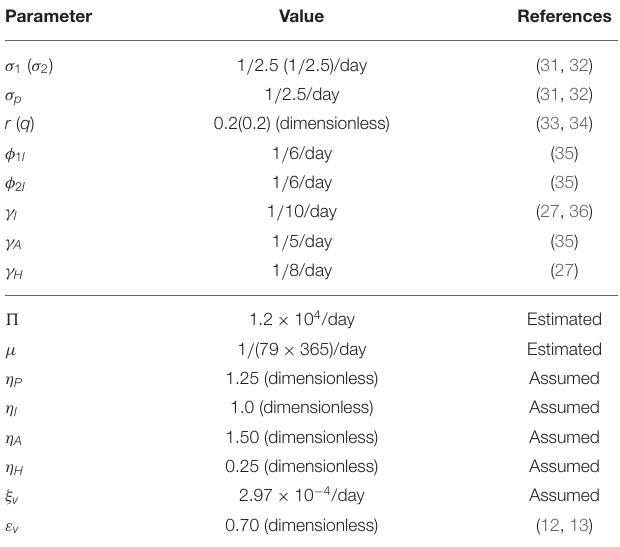
TABLE 4 | Baseline values of the fixed parameters of the model (2.5)–(2.6). Parameter